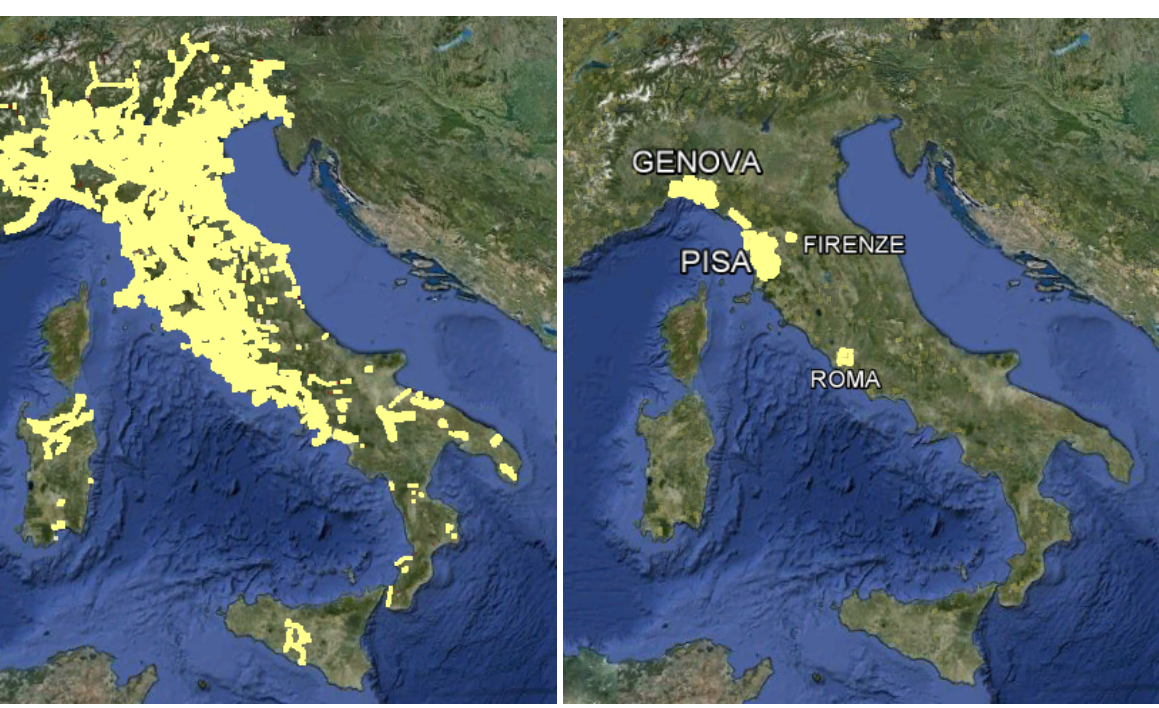
Figure 3. The RAF collection coverage of Italian territory is shown on the left. The yellow area is computed as the union of the regions covered by each photo. Only records that are in the electronic index have been reported in this map. The estimate of the coverage will improve as soon as new physical photos are digitized and georeferenced. On the right, the areas covered by our system at this